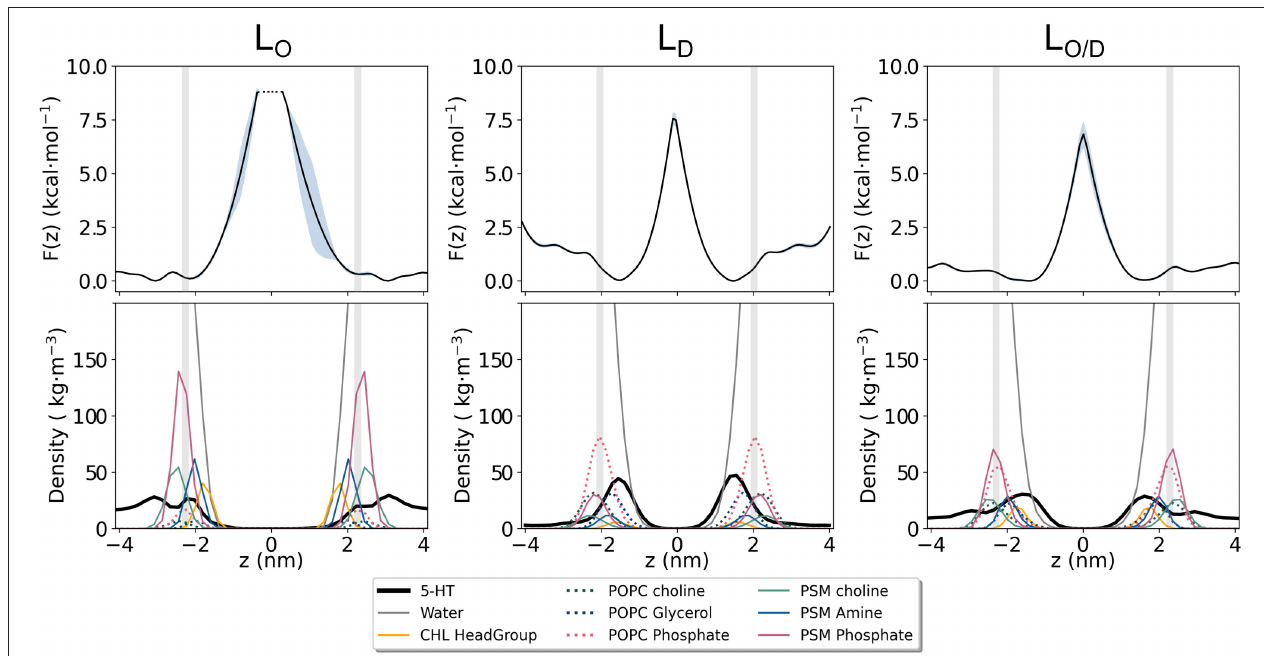
FIGURE 6 | Potential of Mean Force (PMF) for serotonin binding to lipid membranes. Shown is the potential of mean force (Top) as estimated from the serotonin density along the membrane normal z for the L O , L D , and L O / D phase membranes (Bottom) .